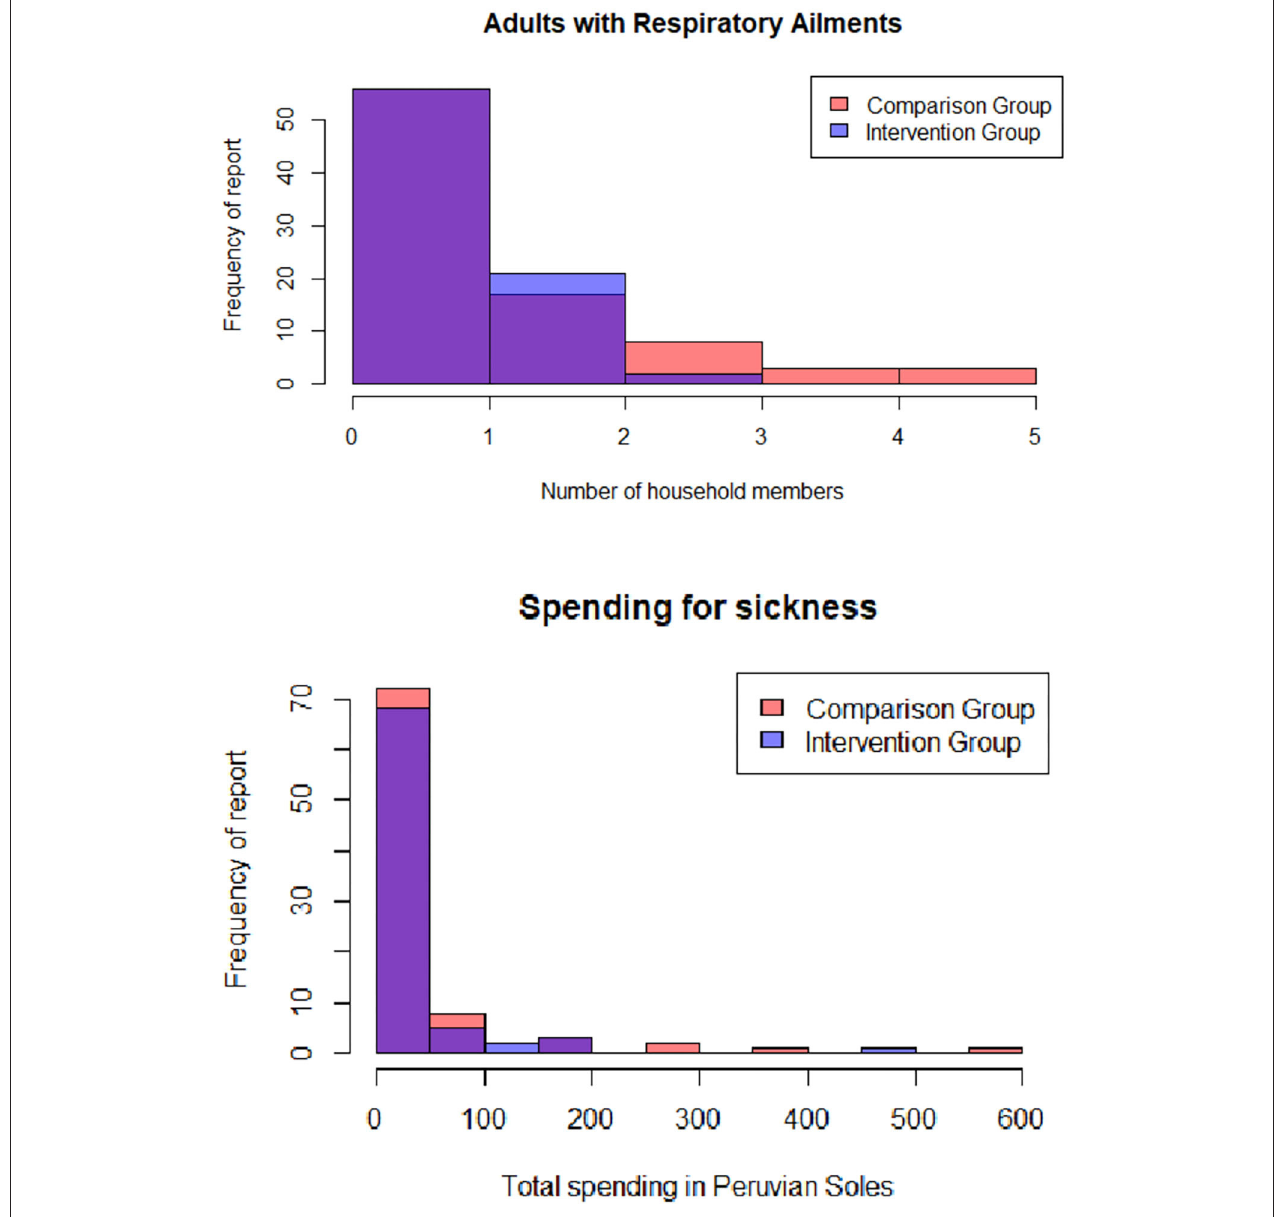
FIGURE 5 | Reported numbers of adults with respiratory ailments and amount spent on sicknesses in the intervention and control